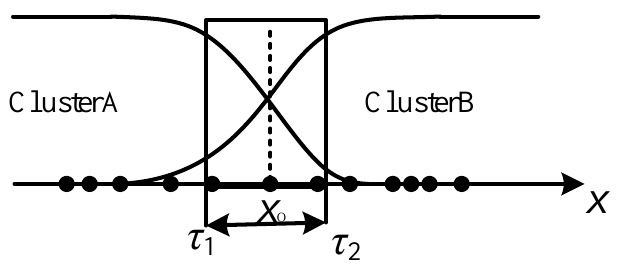
Figure 2. Diagram of uncertain data in one-dimensional data space.